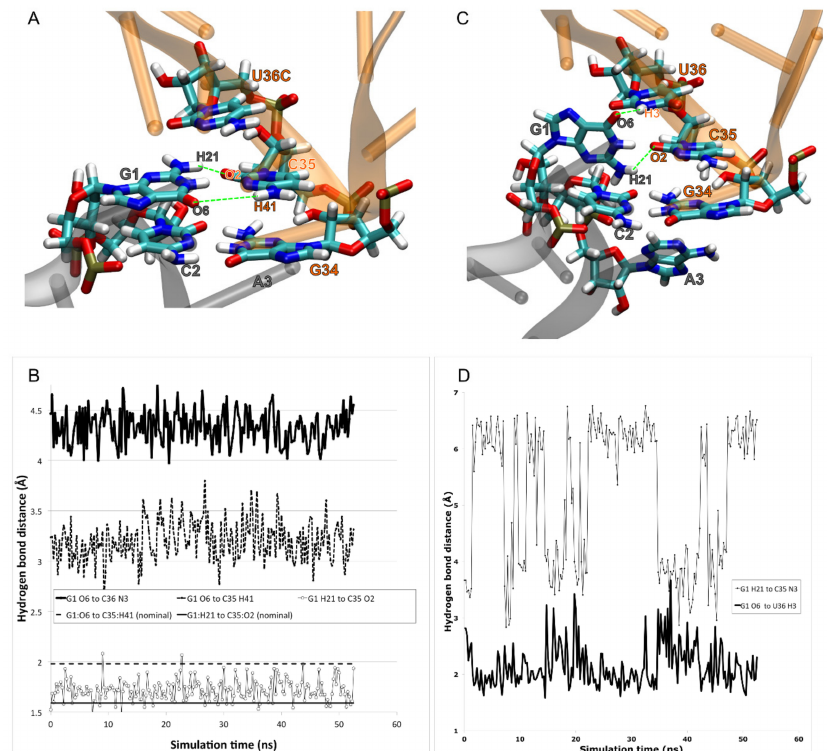
Figure 5. MdMD simulations indicate that the frameshifted configuration of tRNA Ser3 at Ala codons is stabilized by an unexpected interaction between codon position 1 (G1) and anticodon position 1 (U36), rather than by doublet decoding, explaining the loss of binding in the U36C mutant. ( A ) We prepared the tRNA Ser3 U36C mutant in the doublet decoding configuration. The two codon–anticodon base pairs (G1-C35, C2-G34) were approximately maintained during minimization and simulation. ( B ) The hydrogen bonds, however, were longer than has been observed elsewhere, suggesting that this interaction is not strong. ( C ) We similarly prepared the wild type (U36) in the doublet configuration, but G1 rotated away from C35 to interact instead with U36. ( D ) The hydrogen bond between G1:O6 and U36:H3 appeared strong and persistent. A weak interaction occurred between G1:H21 C35:N3.